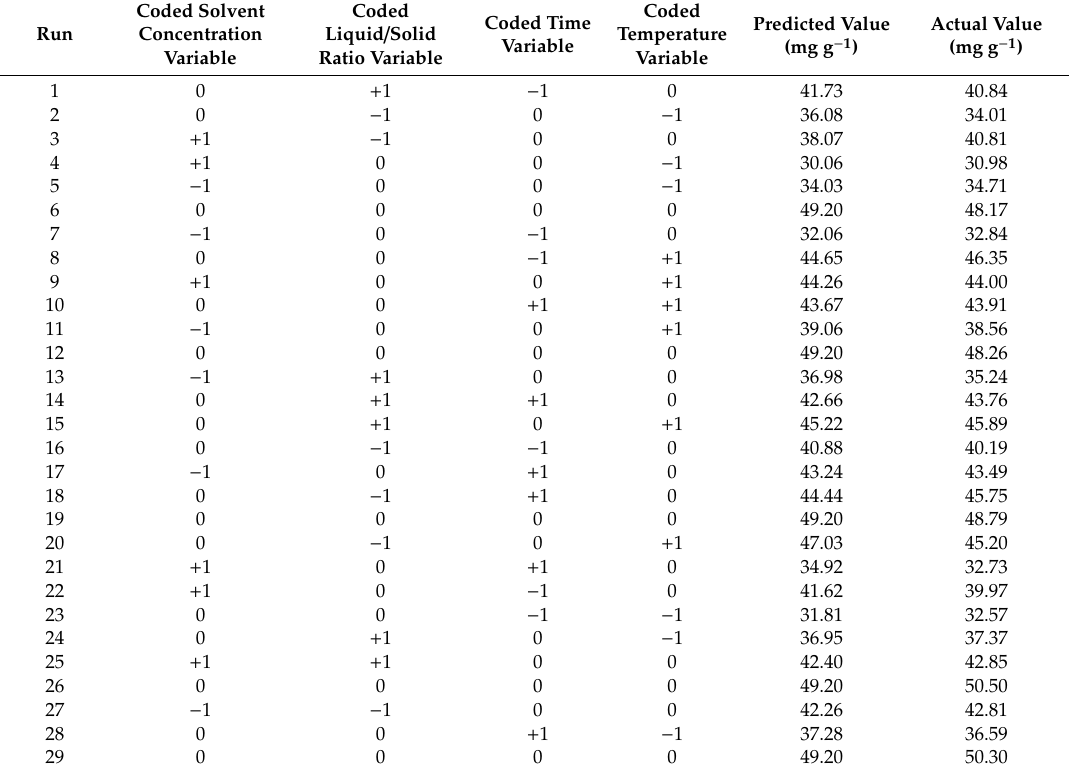
Table 2. Response surface design and experimental data.